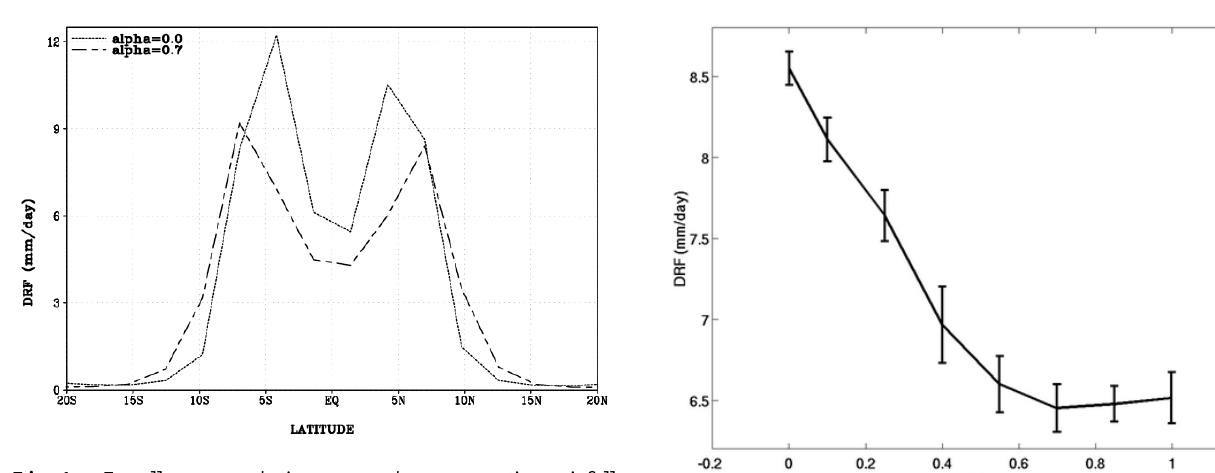
Fig. 1. Zonally averaged time mean deep convective rainfall (mm/day) with α =0 and α =0.7.